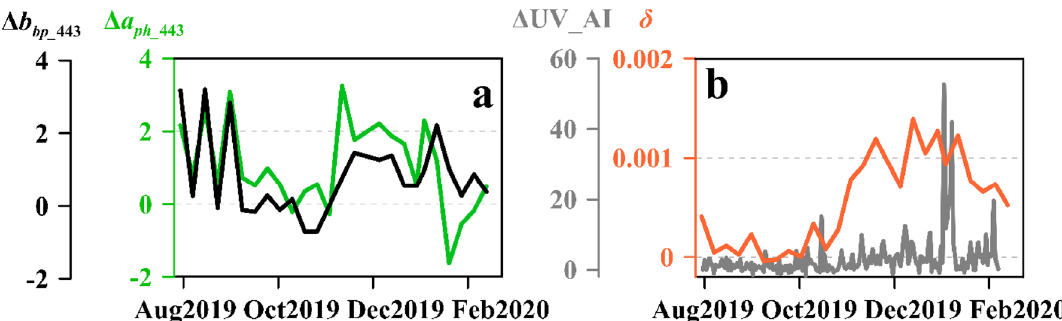
Figure 5. ( a ) b bp_ 443 and a ph_ 443 surface ocean anomalies in P1 between December 2019 and mid-February 2020, ( b ) residual scattering coefficient δ in surface water and ΔUVAI in